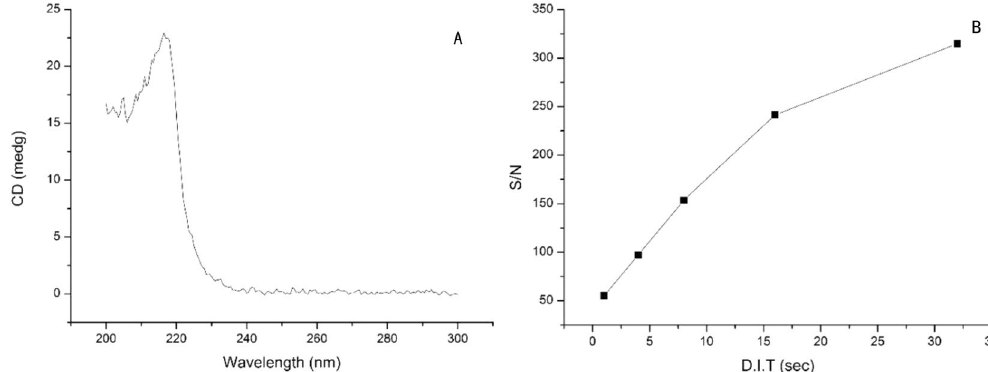
Figure 2. ( A ) Circular dichroism spectrum of a 0.1 mg/g L-phenylalanine solution. (The maximum signal intensity was obtained at 216.5 nm). ( B ) The signal-to-noise ratio with different DIT times. (As the DIT time increased, the signal-noise ratio